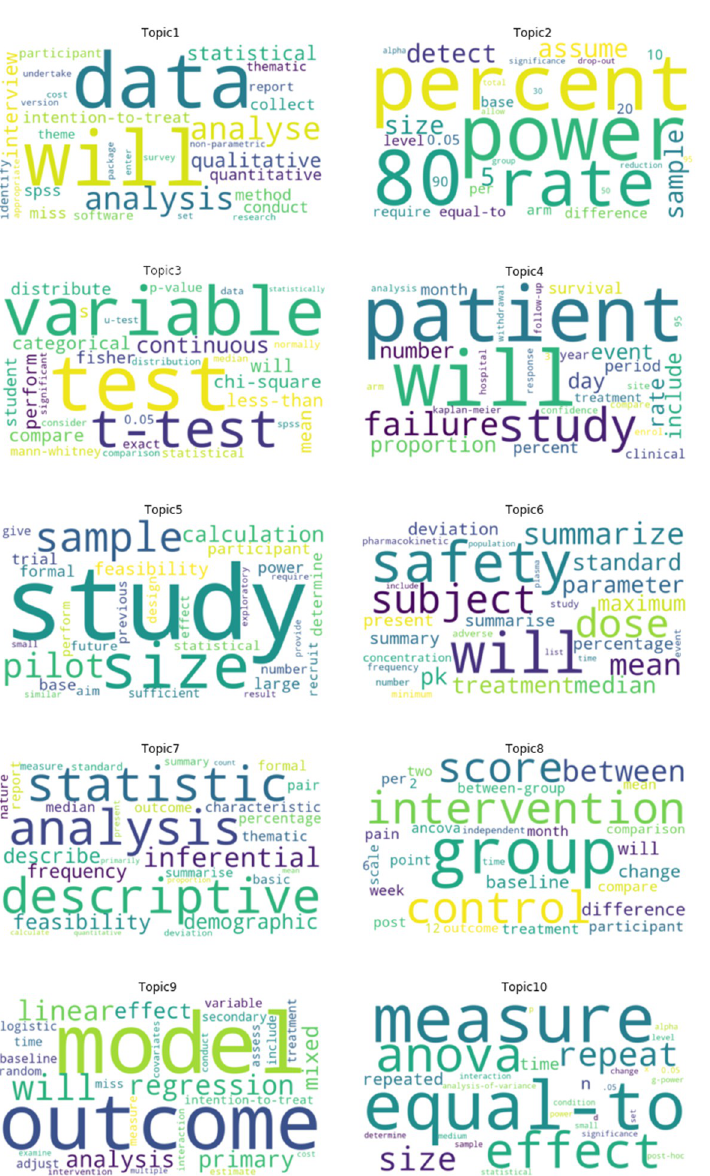
Fig 2. Word clouds for ten topics for statistical methods sections published in